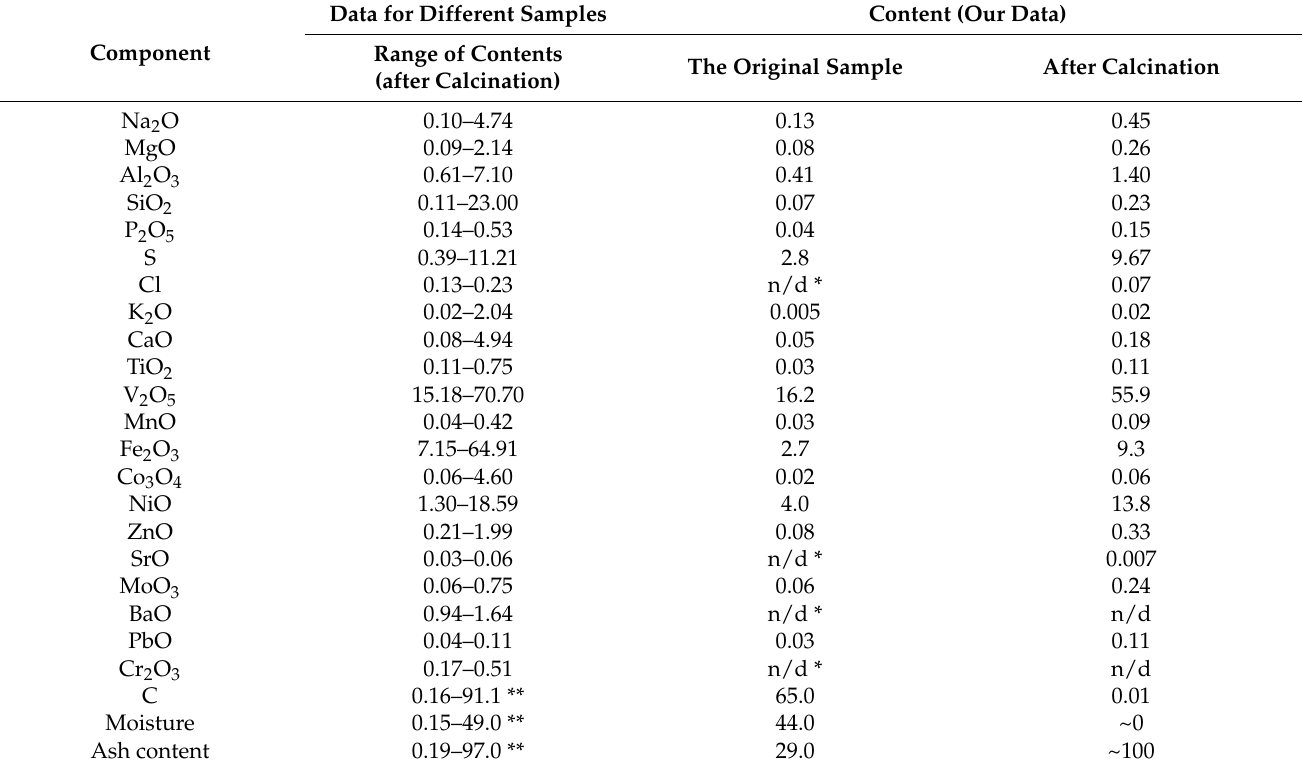
Table 1. Chemical composition of ash samples from fuel oil combustion,